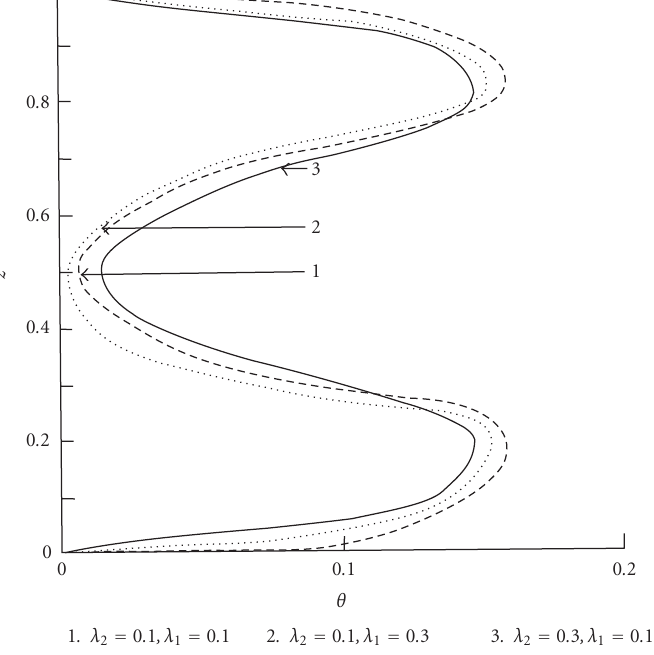
Figure 6.3. E ff ect of velocity relaxation time ( λ 1 ) and thermal relaxation time ( λ 2 ) on unsteady tem- perature profiles in a two-phase fluid when σt = Π / 2, k = 0 . 3, E c P r = 100.